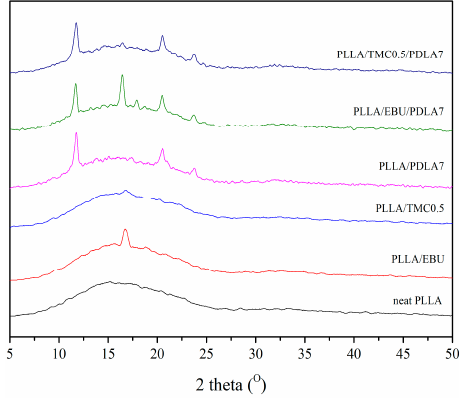
Figure 5. WAXD patterns of nucleated